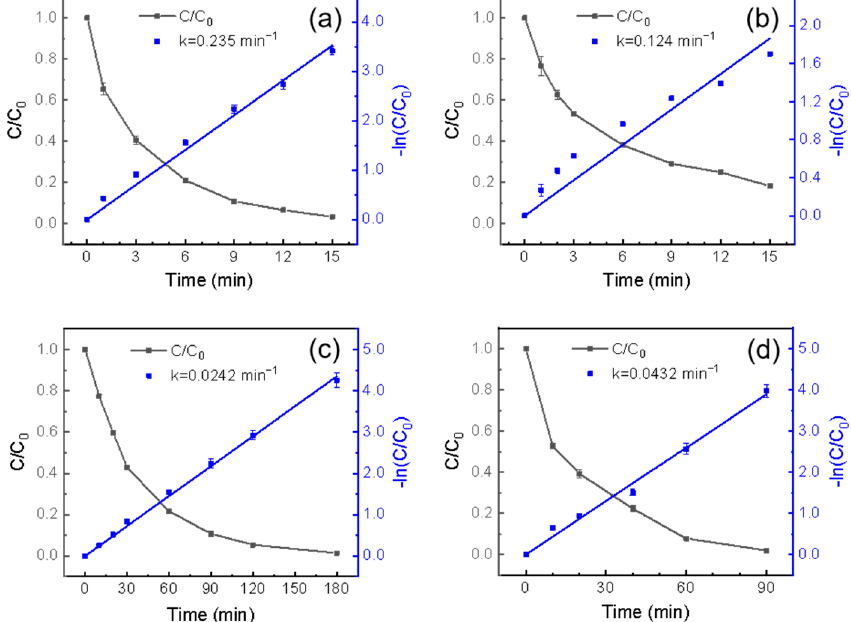
Figure 1. The photodegradation of ( a ) SMX and ( b ) ENR under UV irradiation, and ( c ) SMX and ( d ) ENR under simulated solar light.